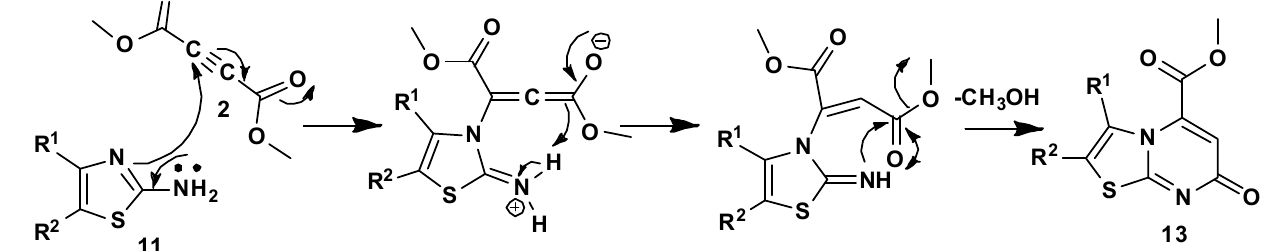
Table 3. Isolated yields of 13a–i from one-pot, three-component reaction.